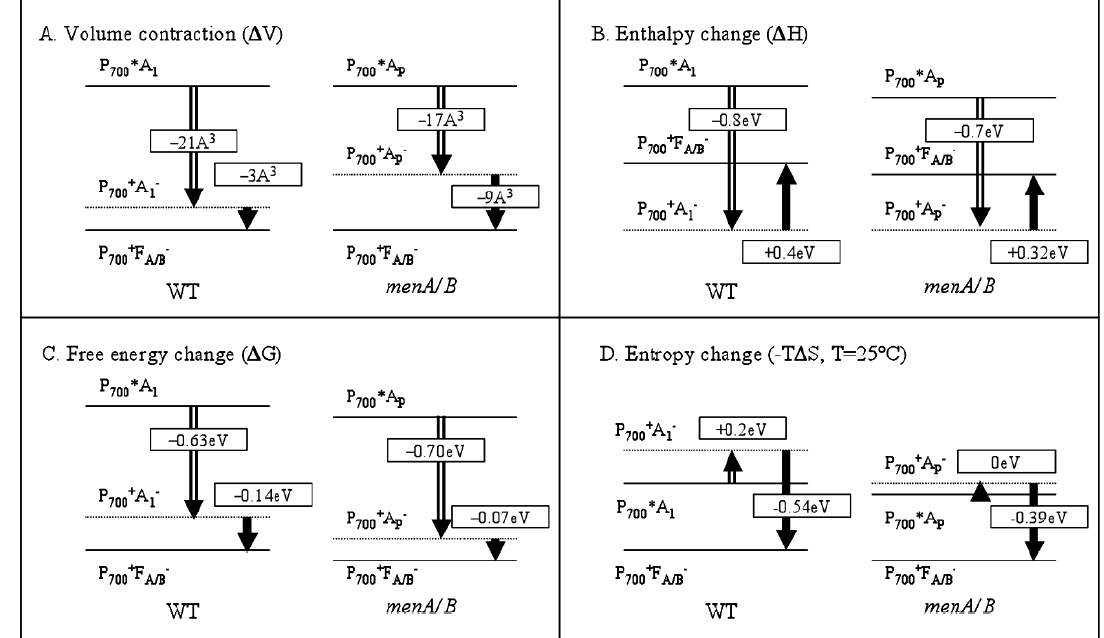
Figure 7. Thermodynamic parameters of charge separation in menA/B PS I and wild-type PS I from Synechocystis 6803 (reproduced with permission from the American Chemical Society